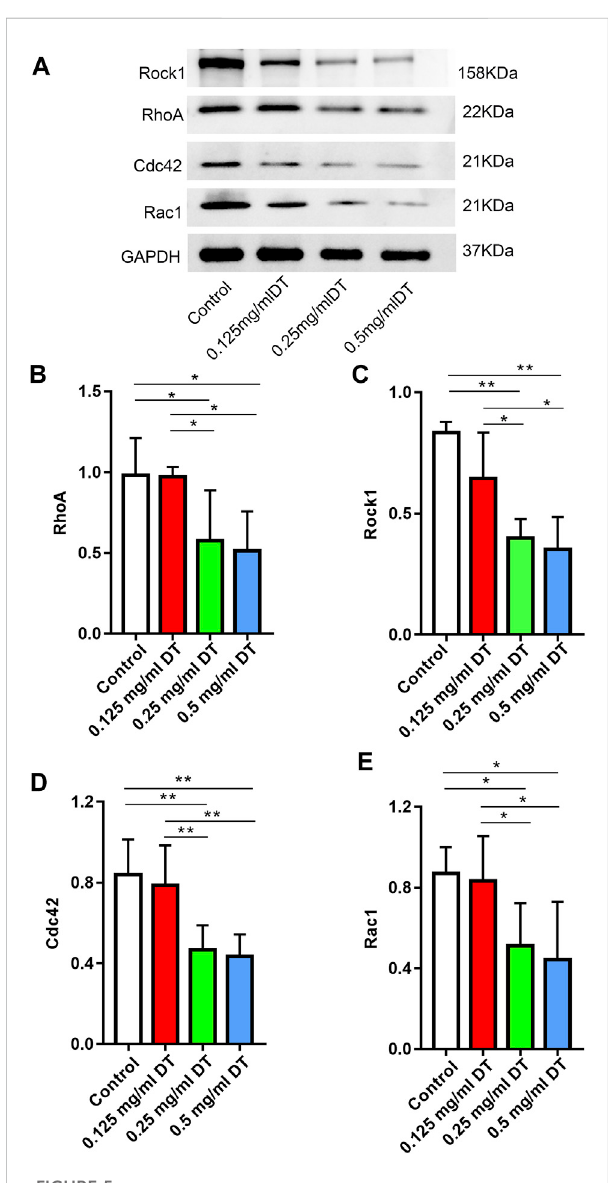
FIGURE 5 (A) Western blotting assay analyzed the levels of RhoA, Rock1, Cdc42, and Rac1 in AMESCs incubated with control, 0.125 mg/mL DT, 0.25 mg/mL DT, and 0.5 mg/mL DT. (B – E) Quantitative analysis